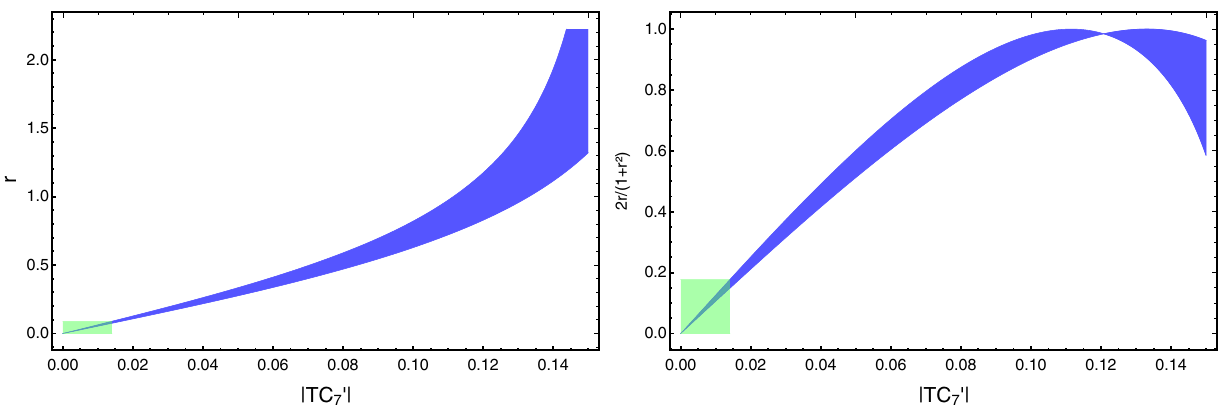
Fig. 2 The polarization fraction r , Eq. (32) and 2 r /( 1 + r 2 ) , which quark models is indicated by the green box. Model-independently, and | (blue shaded band) for the in generic SUSY models, there is no upper limit on drives A (cid:5) , Eq. (11), as a function of | TC (cid:9) 7 current data on B assuming r 0 (cid:8) 0. The range accessible by lepto-